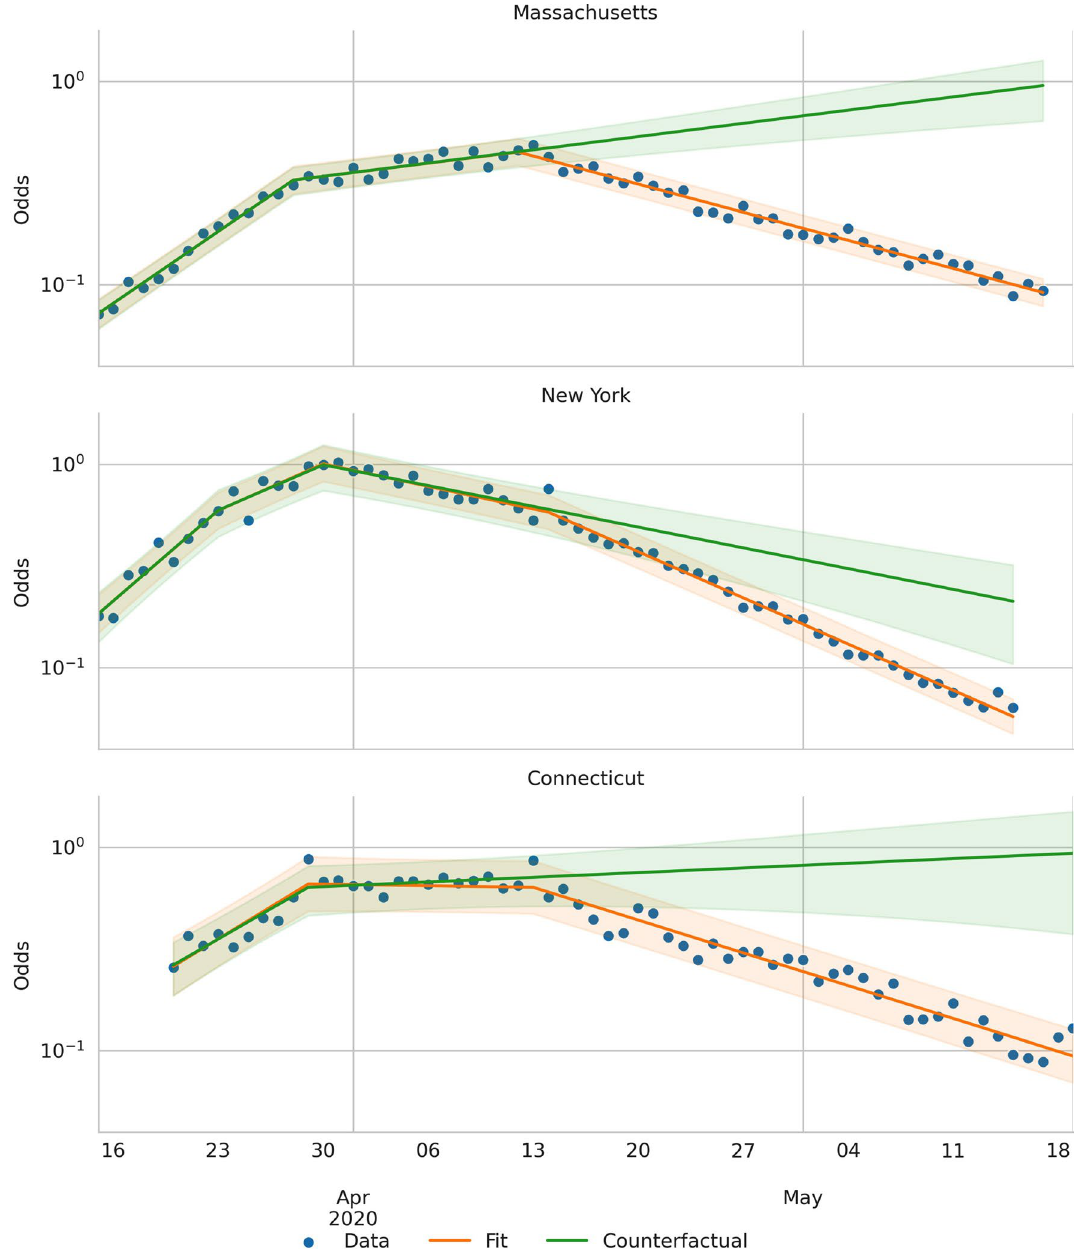
Figure 4. Actual and counterfactual scenarios. The blue dots are the data points. The orange lines show the regressed model, and the orange shades are the 95% CI. The green lines show the counterfactual odds of the scenario where masks were not recommended; in causal inference jargon, do(not masks) ; and the green shaded areas are the 95%